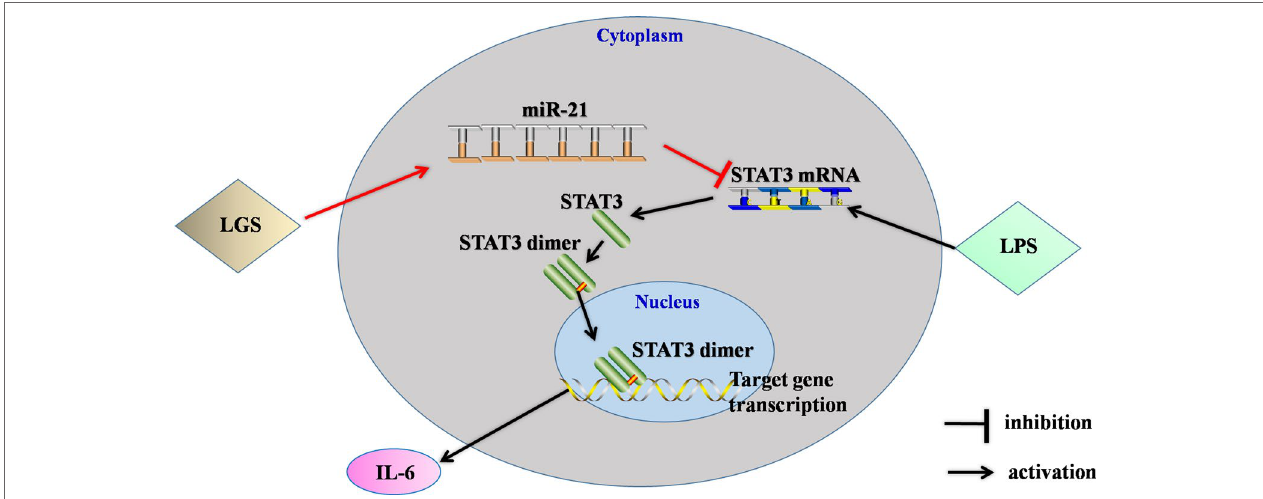
FIGURe 8 | The speculated anti-inflammatory network of LGS. ┴ indicates an inhibitory effect. LGS exerts anti-inflammatory effects through up-regulation of miR- 21, and subsequently inducing suppression of the STAT3 signaling pathway to decrease the release of IL-6.